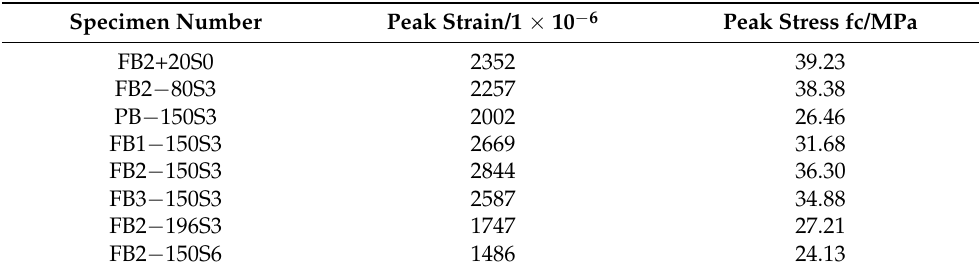
Table 4. BFRC uniaxial compression peak strain and peak